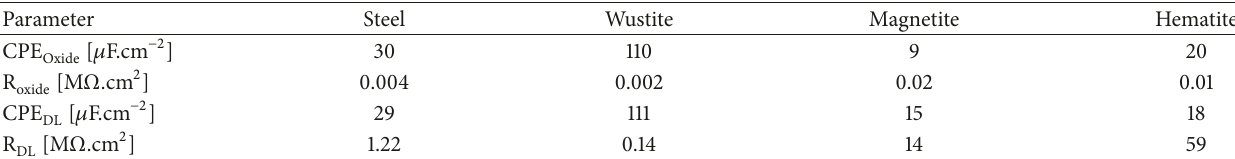
Table 6: Parameter data obtained from the equivalent circuit fitting for samples exposed in sat. Ca(OH) 2 . The data values are an average of two samples.